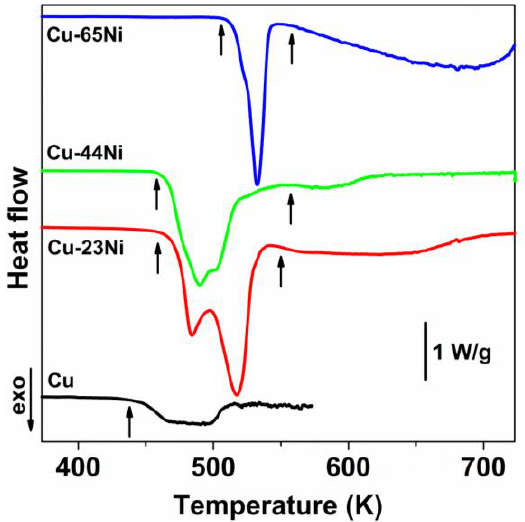
Figure 6. High Pressure Differential Scanning Calorimetry (HP-DSC) traces of the oxide microtubes under hydrogen atmosphere.